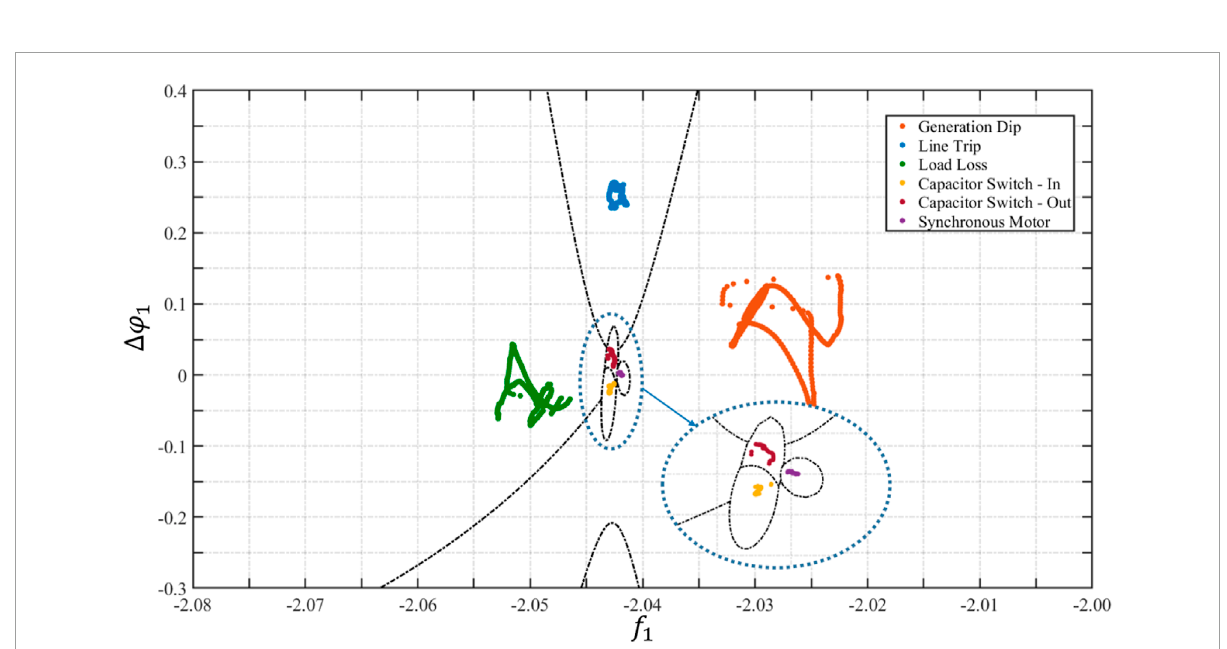
FIGURE 5 PSEC classification results for six simulated case